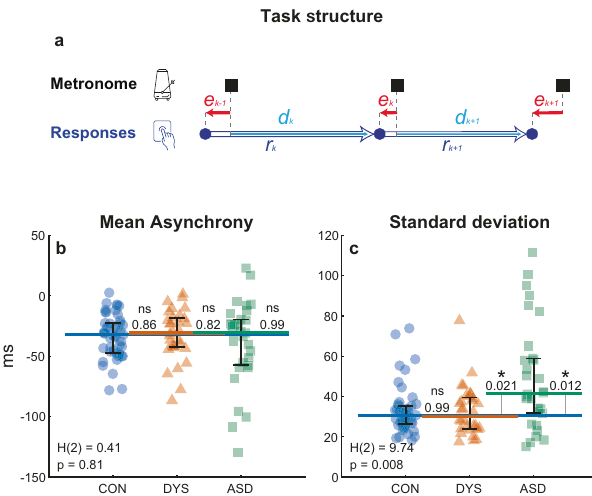
Fig. 1 Isochronous fi nger tapping: mean asynchrony is similar in the three groups, but variability around this mean is substantially larger in Autism (ASD) compared to neurotypical (CON, control) and dyslexia groups (DYS). a A schematic illustration of the temporal structure of paced tapping: metronome stimuli (presented every 500 ms, black squares), and fi nger-tap responses (blue circles) as a function of time; e k - error (asynchrony, typically negative) in tap k ; r k - inter-tap interval; d k - delay interval from the previous metronome stimulus (beat k-1 ) to the following fi nger tap (tap k ). Note that r ¼ d (cid:2) e k k k (cid:2) 1 . b , c Basic tapping parameters: b Mean asynchrony is negative for all three groups ( p < 0.001) and similar in the three populations, though more broadly distributed in the ASD group. c Standard deviation is larger in the ASD group compared to the two other groups. Each dot represents the performance of one participant (average of two blocks); the y-axis represents the score in ms, and x-axis and color represent group membership (with a small jitter for readability): blue circles — neurotypical, red triangles — dyslexia, and green squares — ASD. The median of each group is denoted as a line of the same color; error bars around this median denote an interquartile range. Kruskal – Wallis H -statistic and corresponding p values are plotted in the bottom-left corner; p values of comparisons between groups are plotted next to the line connecting the groups ’ medians. N = 109 subjects ( N CON = 47, N DYS = 32, N ASD = 30). Source data are provided as a Source Data fi le. Though there are a few outlier results in both mean asynchrony and standard deviation of participants with ASD, these are not the same individuals — scores on these two measures were not correlated in the ASD and dyslexia groups (Spearman correlations: ρ ASD ¼ (cid:2) 0 : 2 ( p = 0.3), ρ DYS ¼ (cid:2) 0 : 24 ( p = 0.18)). A signi fi cant correlation was found only in the neurotypical group ( ρ CON ¼ (cid:2) 0 : 37, p = 0.01, uncorrected). Statistical tests are two-sided unless stated